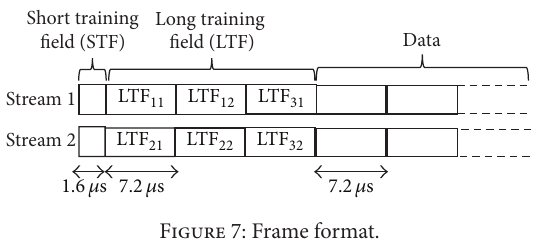
Figure 7: Frame format.